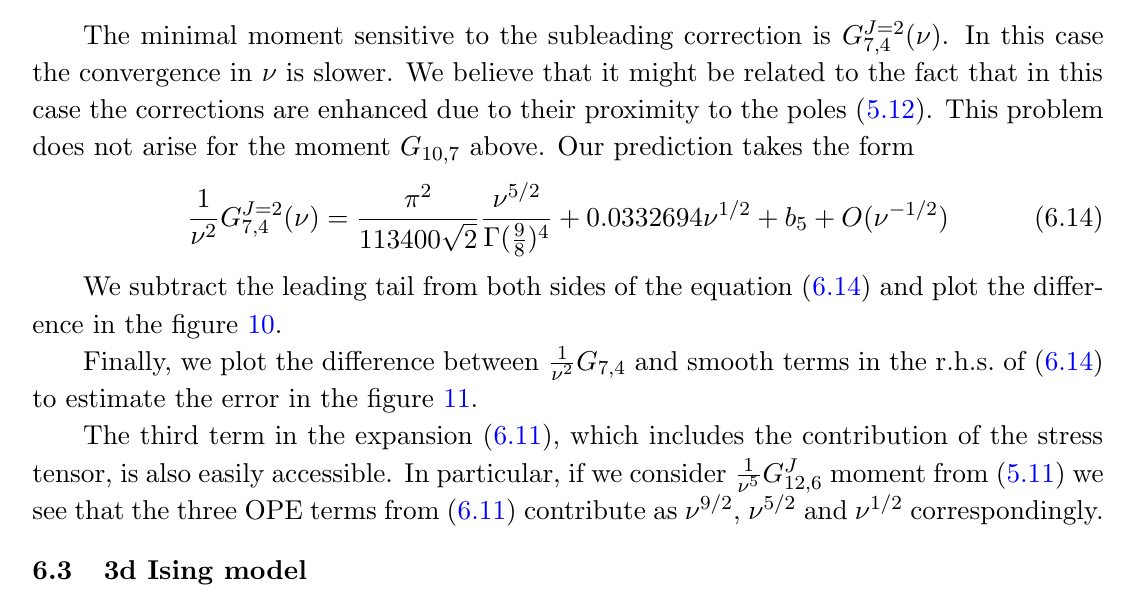
Figure 9 . Error estimate for 1 l.h.s. and the smooth terms in the r.h.s. in (6.13) by with the last term in